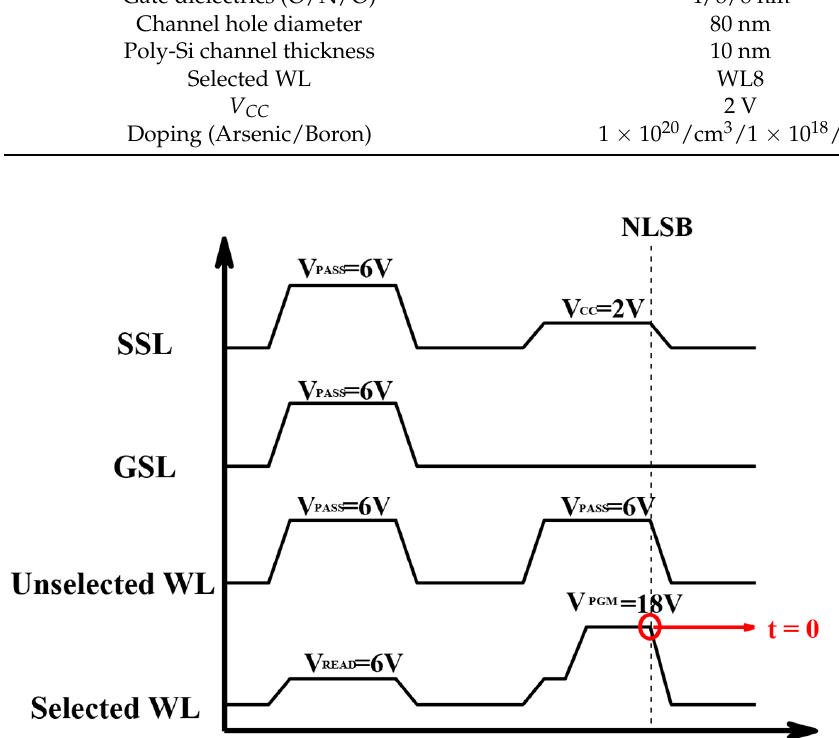
Figure 2. Timing diagram of NLSB ( V CC = 2 V, V PASS = V READ (read voltage) = 6 V, V PGM = 18 V).